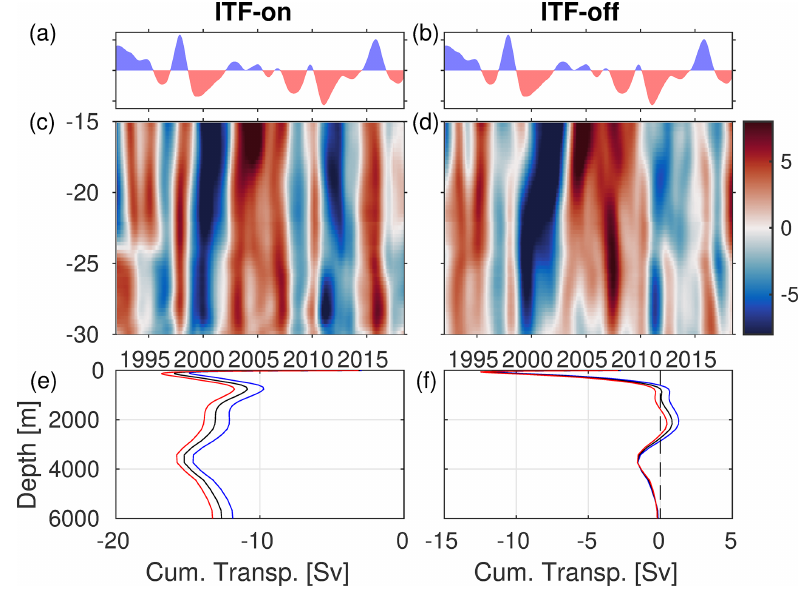
Figure 12. (a, b) Time series of the standardized MEI (El Niño and La Niña are shown by blue and red shading, respectively). (c, d) Zonal differences of SLA (cm) computed between 50–55 ◦ E and 110–115 ◦ E (SLA west –SLA east ) as a function of latitude and time in the ITF-on and ITF-off experiments. (e, f) Time-mean stream function of the meridional flows across 15 ◦ S (black line) and the composite of the stream function associated with El Niño (blue line) and La Niña (red line) in the ITF-on and ITF-off experiments.